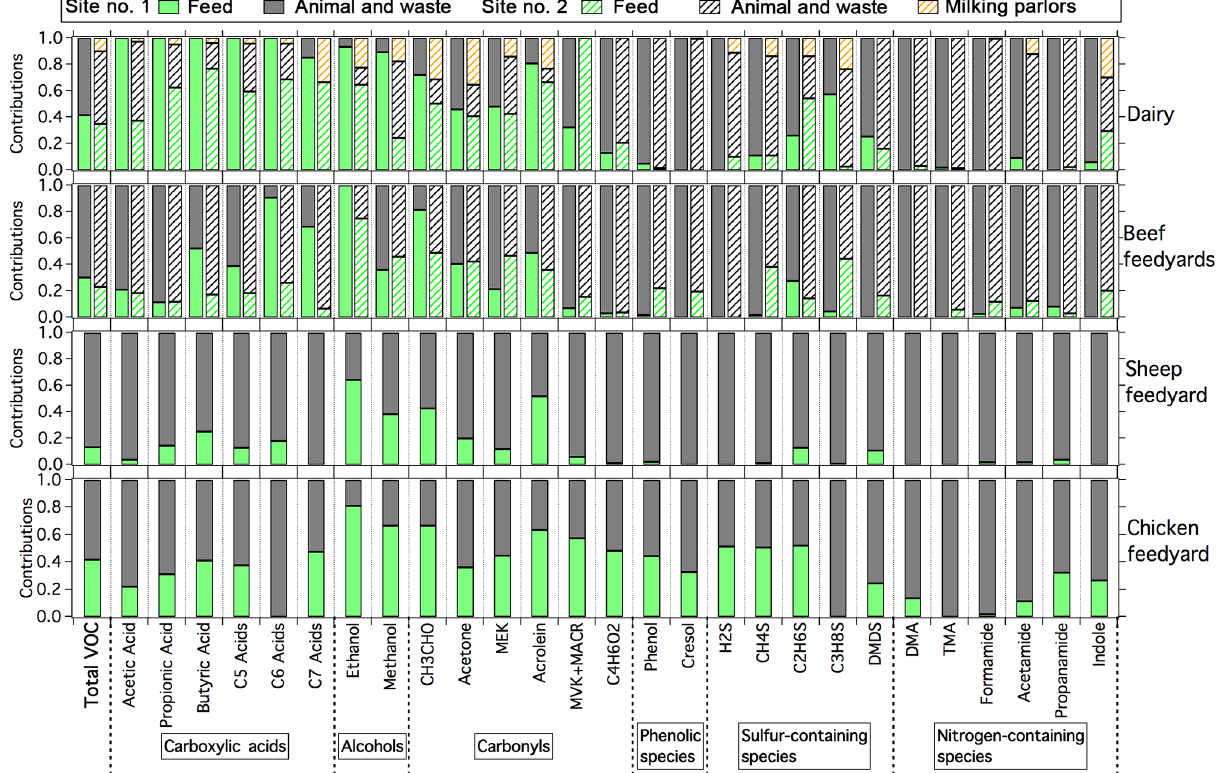
Figure 4. The relative contributions of feed storage + handling, animal + waste and milking parlors (only for dairy farm no. 2) to emissions of different VOC species and total VOC for the investigated CAFO sites. DMDS: dimethyl disulfide; DMA: dimethylamine; TMA: trimethy-